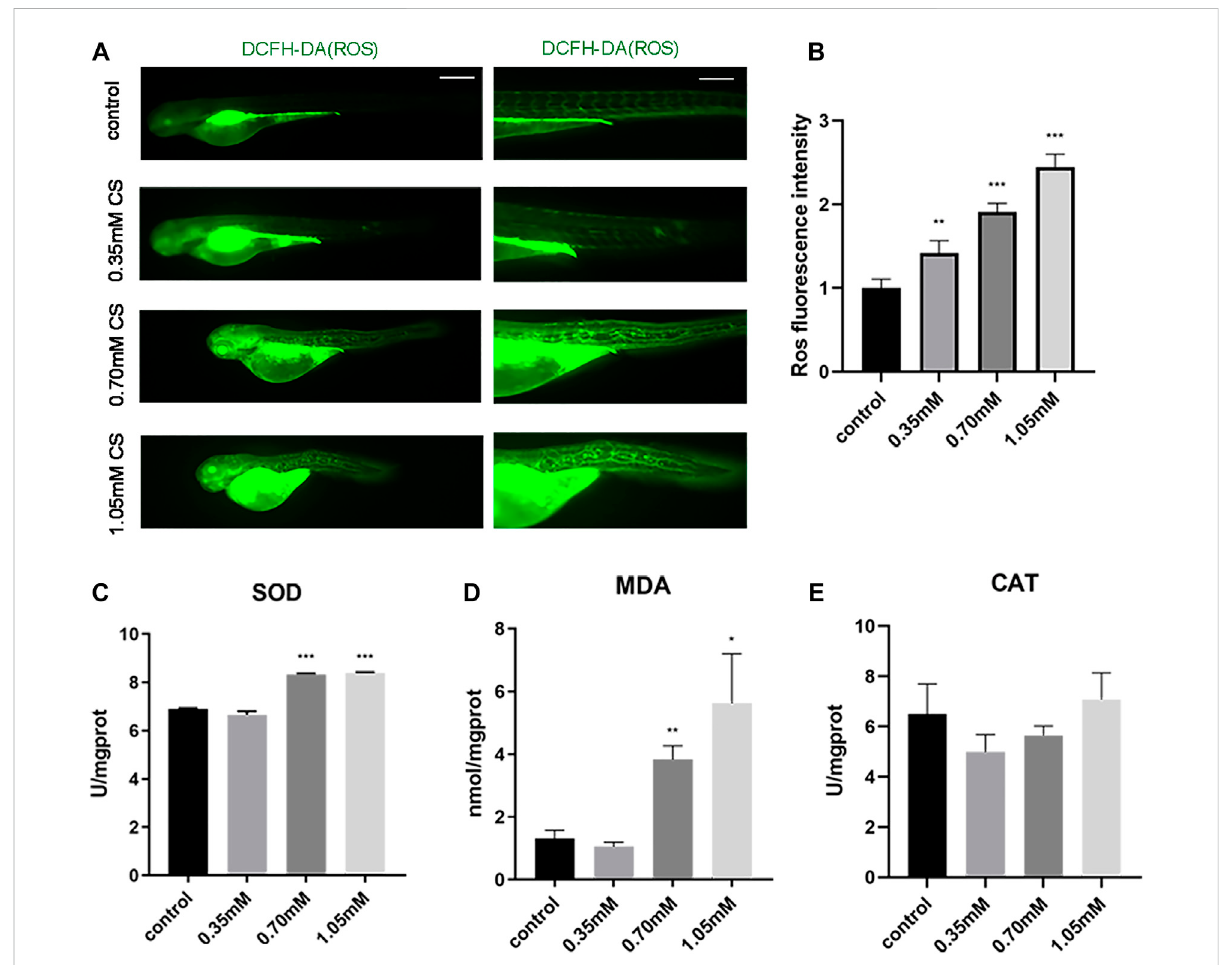
FIGURE 4 Exposure to cysteamine induced oxidative stress. (A) ROS staining. (B) ROS fl uorescence intensity. (C) SOD activity. (D) MDA content. (E) CAT activity. Scale bars: 100 μ m (A) . * p < 0.05, ** p < 0.01, *** p < 0.001, mean ±